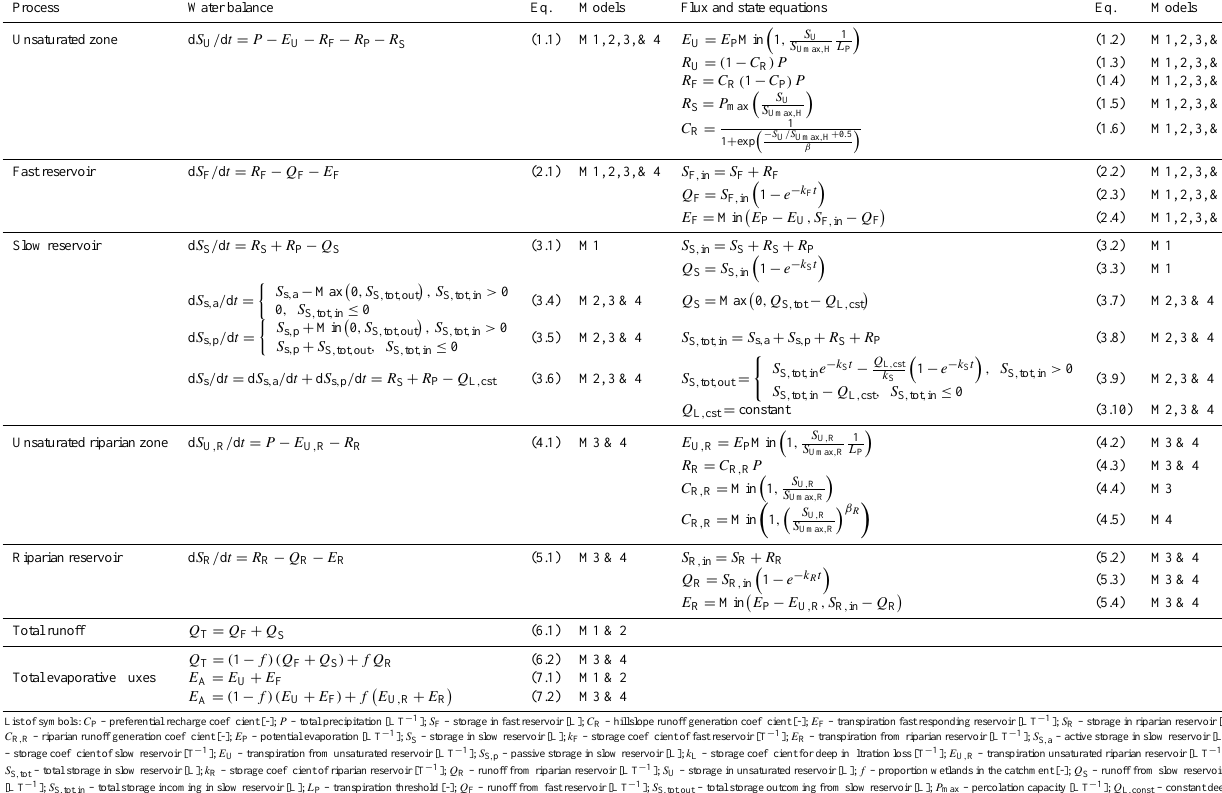
Table 1. Water balance and state and flux equations of the models